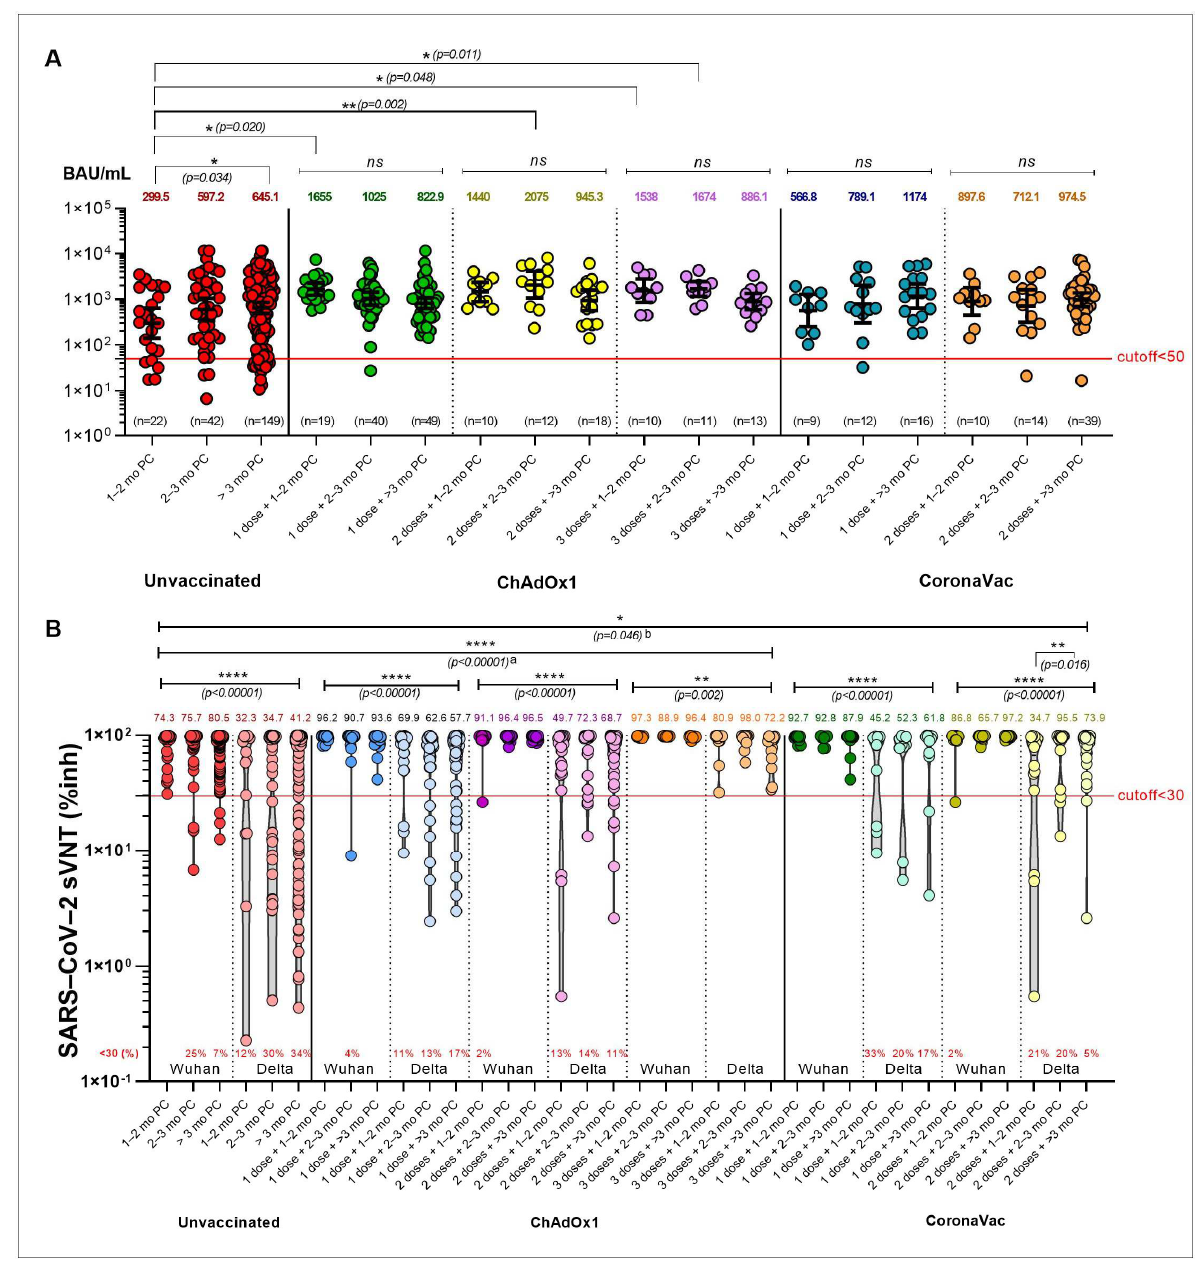
Figure 5. Immune responses after breakthrough COVID-19 infection with prior CoronaVac or ChAdOx1 vaccination during the Delta pandemic. ( A ) The scatter plot of geometric mean titers (GMTs) of SARS-CoV-2 anti-spike protein receptor-binding domain antibodies’ (Anti-RBD IgG) concentrations in serum samples obtained from subjects after COVID-19 infection and with prior various vaccination status (CoronaVac vs. ChAdOx1). Sera at different time points from patients recovered from COVID-19 are shown as reference level (red). ( B ) Scatter plots demonstrate an inhibition rate of Wuhan and Delta RBD-blocking antibodies measured using a surrogate viral neutralization test (sVNT) by vaccination/reinfection status; the lower dot line represents the cut-off level for seropositivity. All sera were from the patients during the Delta pandemic. * p < 0.05; ** p < 0.01; **** p <